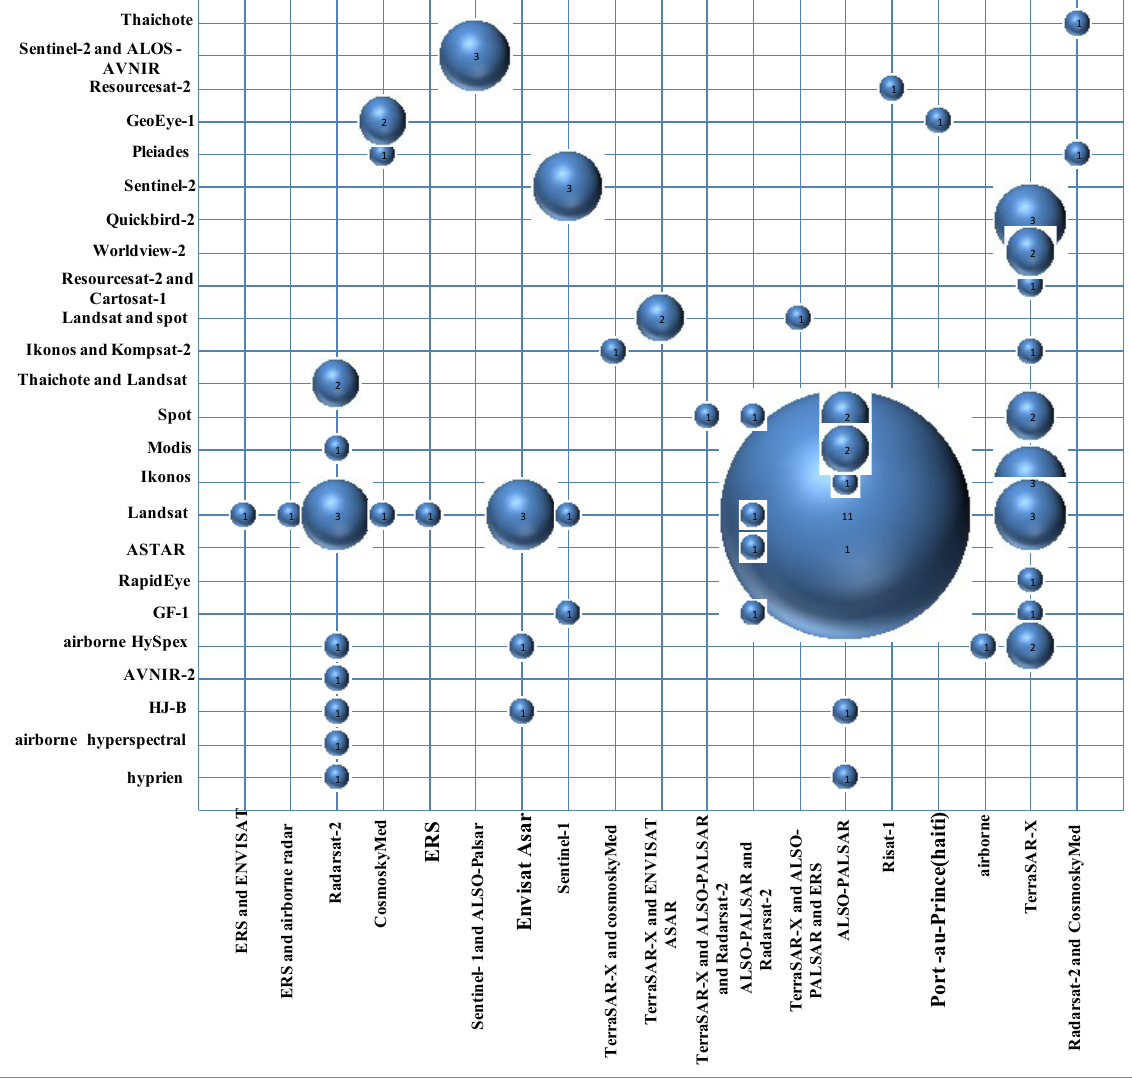
Figure 4: Types of combinations of satellite images used in